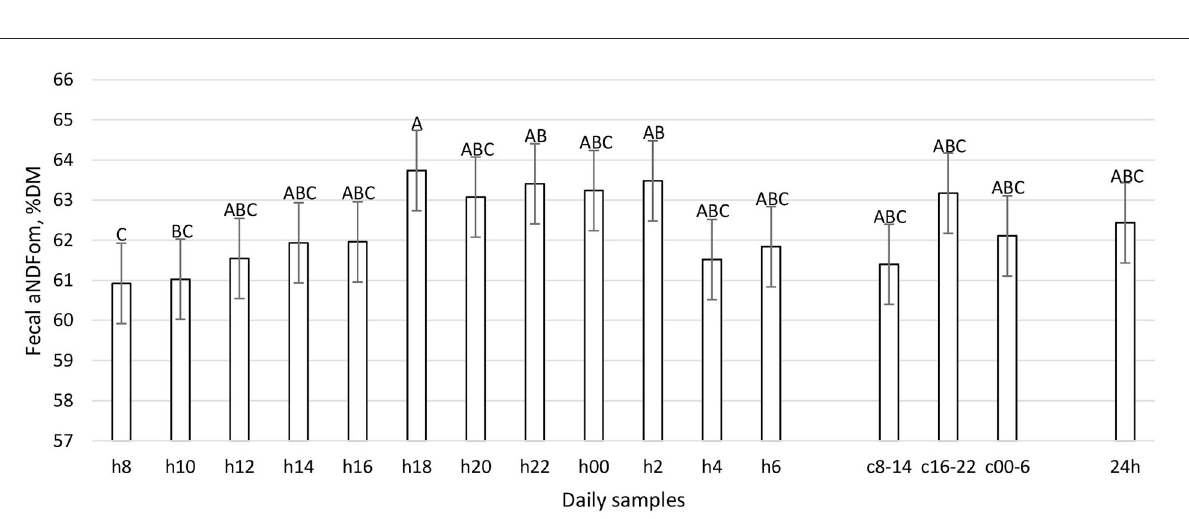
FIGURE7 Fecal aNDFom (%DM) excretion (LSM ± SE) in sampled time points (daily samplings: h8, h10, h12, h14, h16, h18, h20, h22, h00, h2, h4, h6; composites: c8-14, c16-22, c00-6, 24h). Letters for differences ≤ 0.05. P-value < 0.01; SEM =